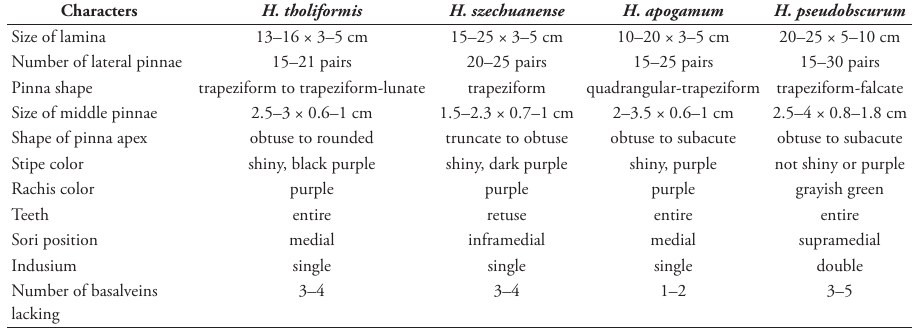
Table 1. Comparison of morphological characters to differentiate Hymenasplenium tholiformis , H . sze- chuanense , H. apogamum, and H. pseudobscurum